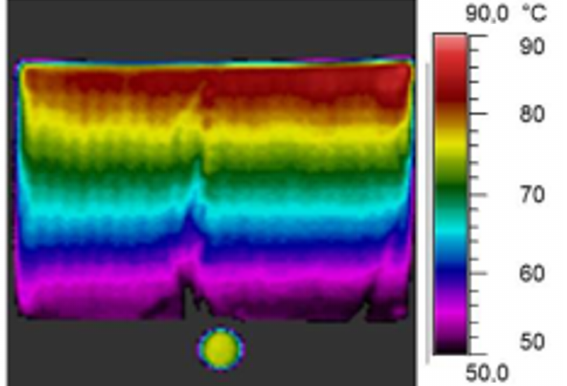
Figure 20. Delonghi -22 radiator—surface temperature distribution according thermography mea- surements, t s = 89.8 ◦ C. t r = 54.0 ◦ C, t i = 19.7 ◦ C, mass flow rate q m = 0.0120 kg/s—measurement